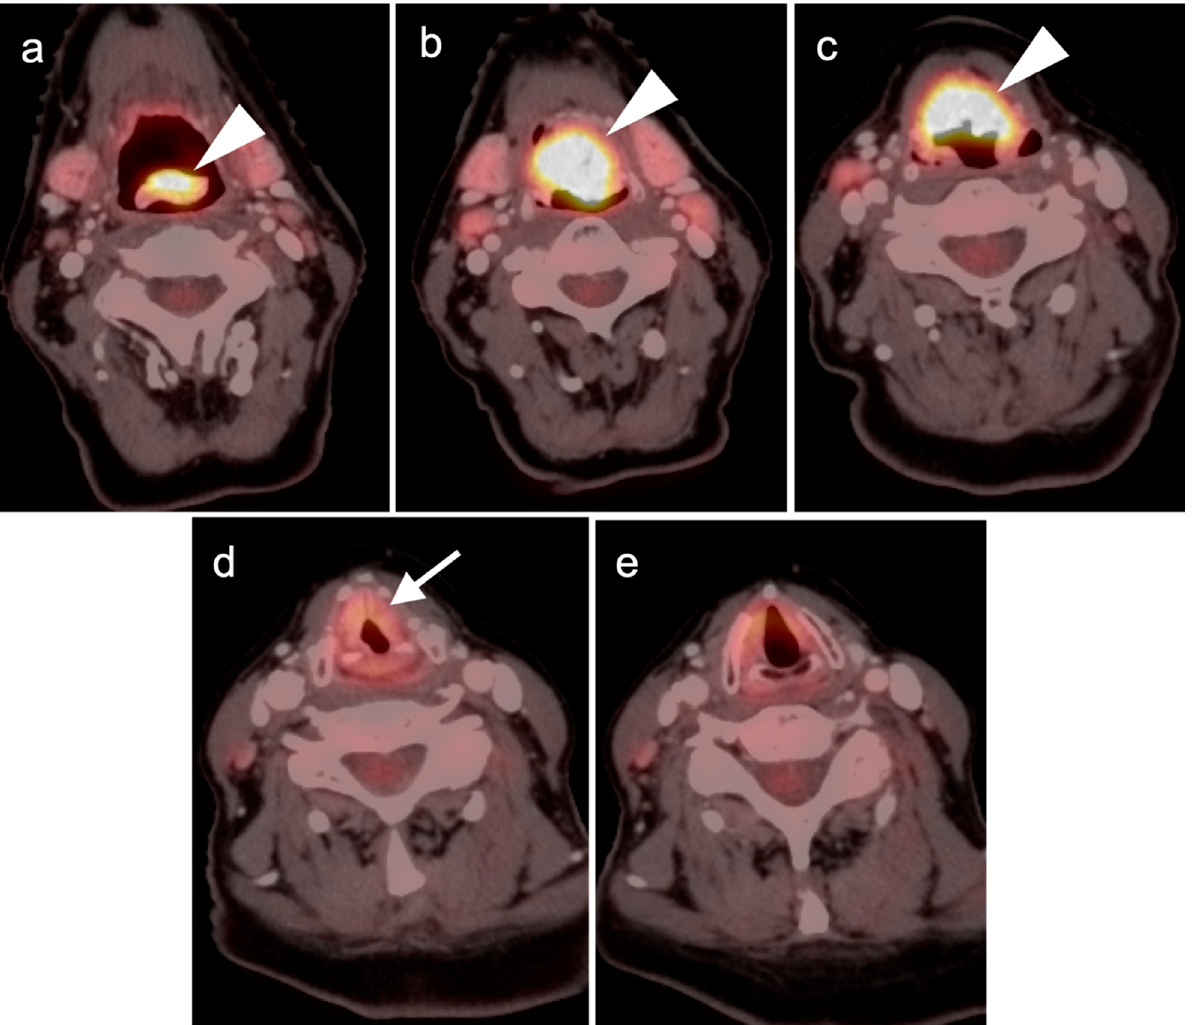
Figure 17. Squamous cell carcinoma of the false cords. ( a ) A large tumor shown in axial ( a ), sagittal ( b ) and coronal ( c ) FDG PET ‐ CT images (white arrows) involves the left false cord and extends across the anterior midline to involve and anterior aspect of the right false cord. The mass effaces the left pyriform sinus and extends to the base of the epiglottis.